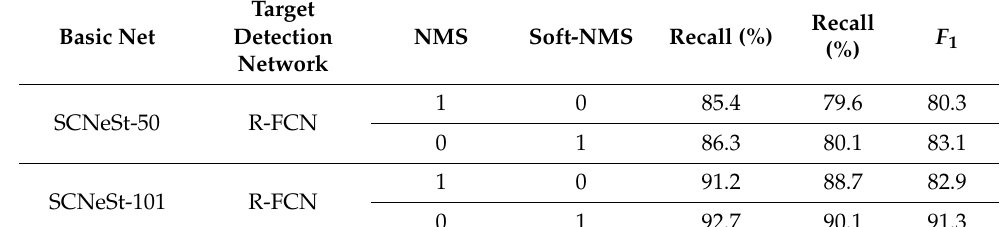
Table 4. Added Soft-NMS network parameter